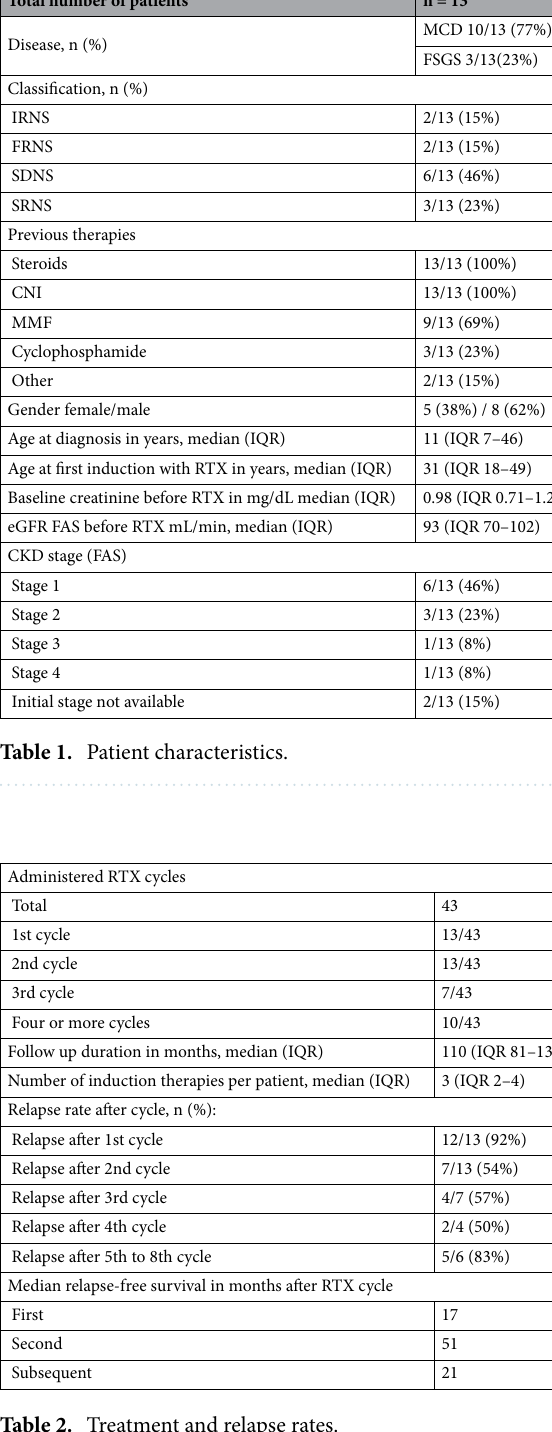
Table 2. Treatment and relapse